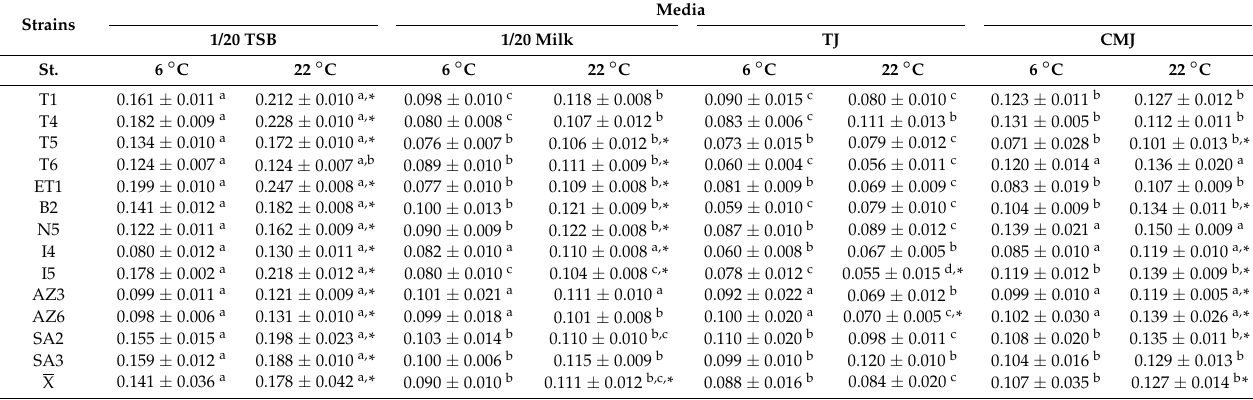
Table 4. Biofilm formation on stainless steel coupons with the four different growth media used at 6 ◦ C and 22 ◦ C by Salmonella strains tested in this study.